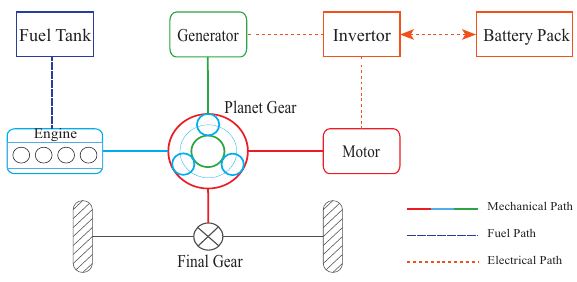
Figure 1. PHEV powertrain system configuration.